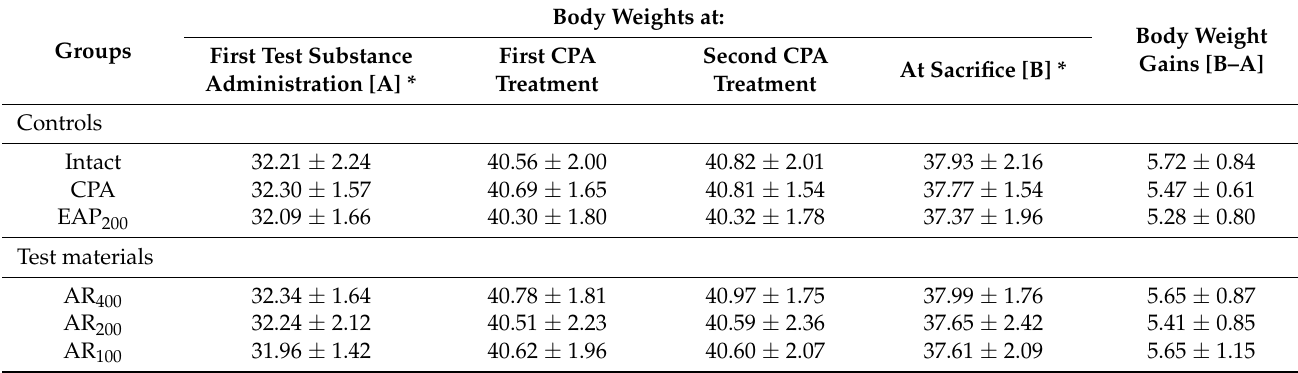
Table 1. Body weight gain in intact and CPA-induced immunosuppressed mice.